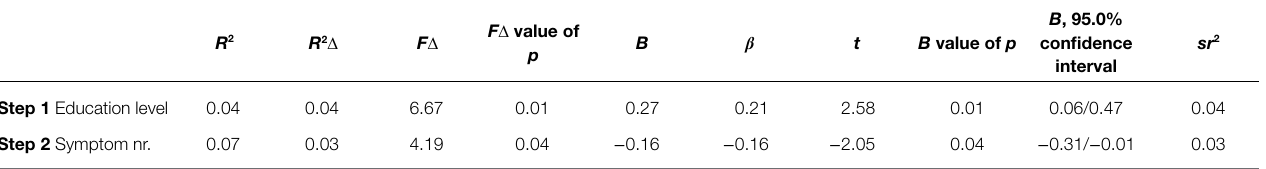
TABLE 6 | Association between number of elevated symptom domains and executive functioning.